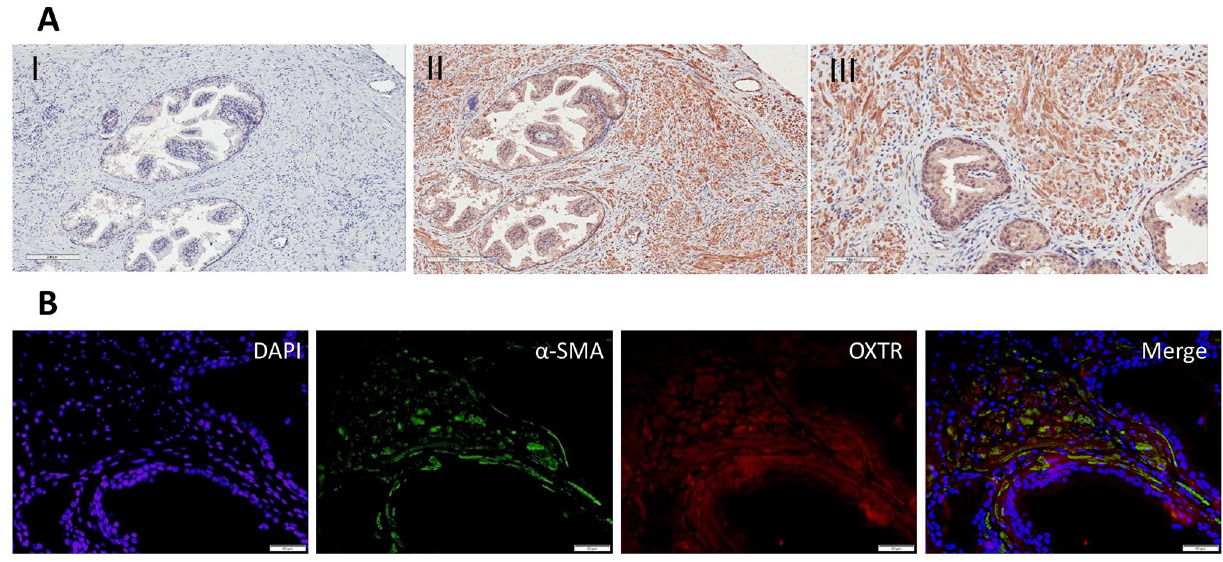
Figure 1. The oxytocin receptor is widely expressed in the human prostate and is co-localised with contractile stromal cells. Representative images of sections of human prostatic transition zone specimens with ( A ) immunohistochemistry staining of (I) negative control (scale bar = 200 μm), and (II, III) oxytocin receptor (OXTR) (scale bar = 200 μm and 100 μm respectively), and ( B ) Immunofluorescence staining of DAPI, α-Smooth Muscle Actin (α-SMA), and OXTR. Merged image demonstrates co-localisation (yellow) (scale bar = 50